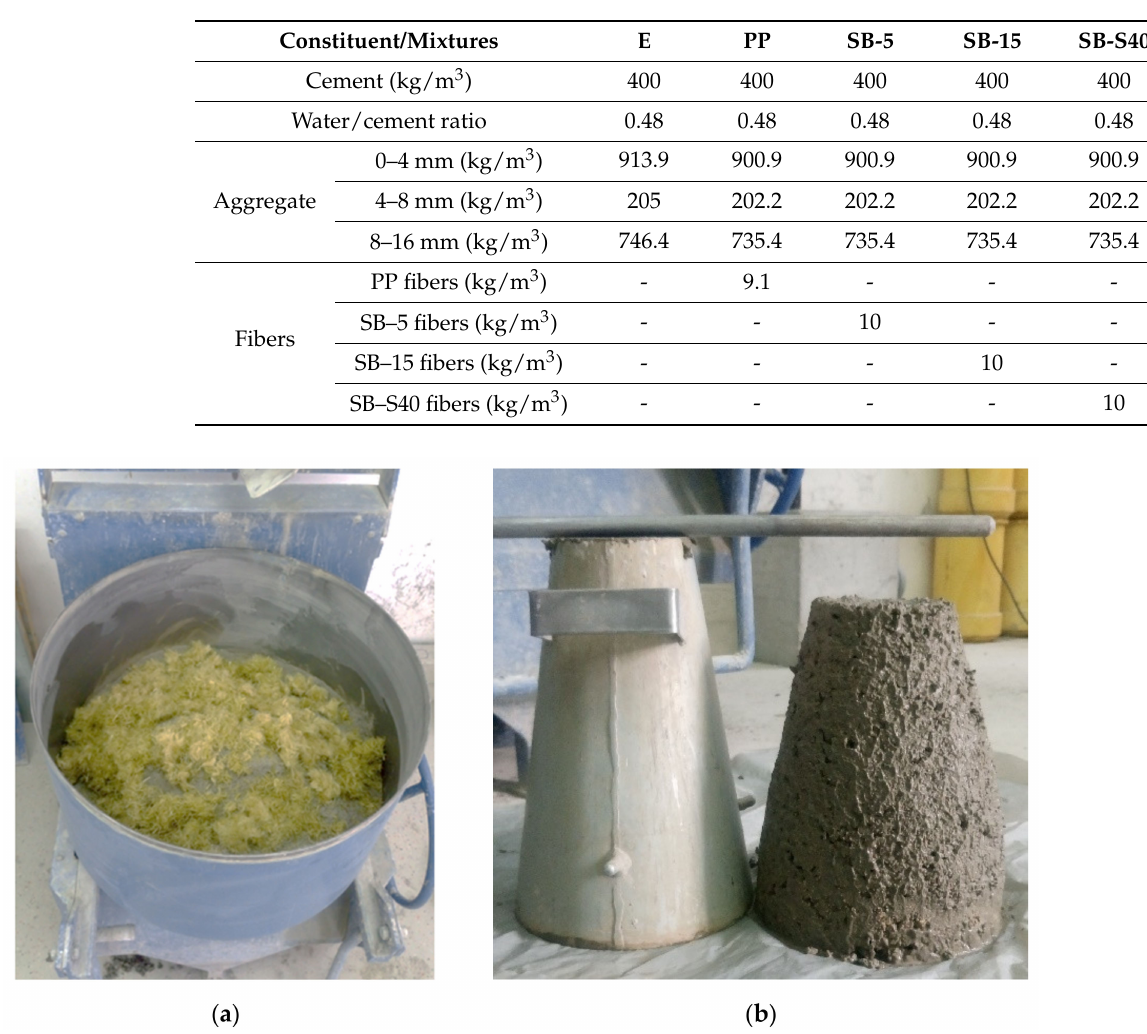
Figure 4. ( a ) Separated Spanish broom fibers in the pan mixer; ( b ) a slump of reference mixture